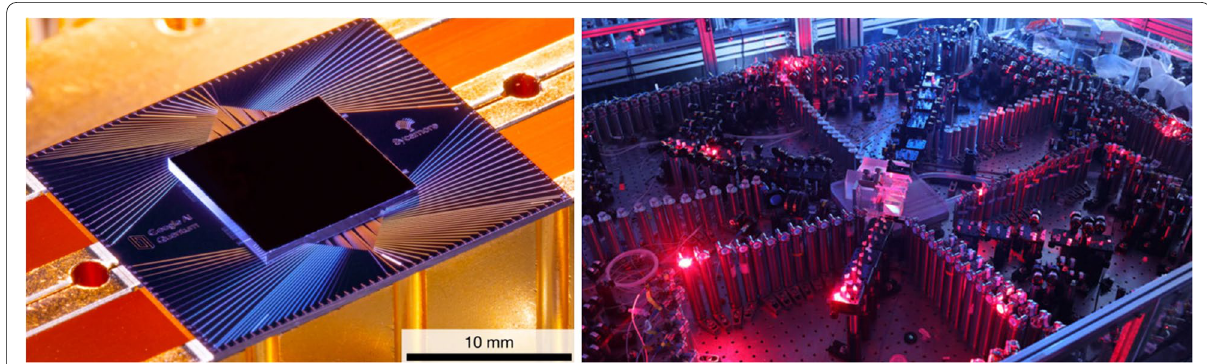
Fig. 2 Figures taken from [41] and [42], with permission granted. Pictures of the two quantum computers to first claim quantum supremacy. The left picture is the superconducting qubit chip from Google, and the right picture is the Jiuzhang photonic quantum computer from